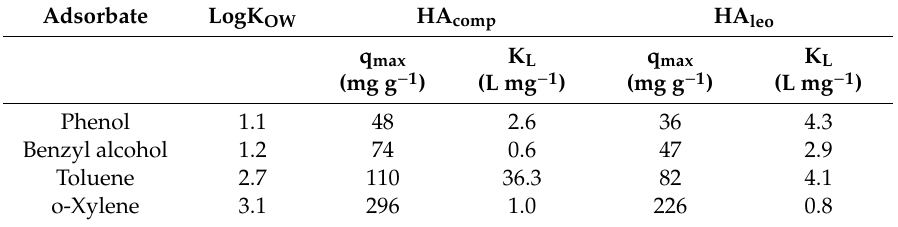
Table 7. Sorption parameters for the selected sorbates onto HA comp and HA leo (adapted from [97]). Adsorbate LogK OW